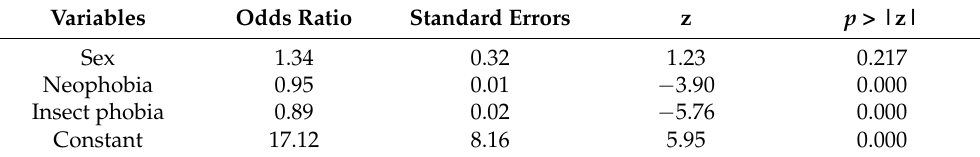
Table 7. Results of the second logit model (Model 2) of the intention to eat food that contains insects. Variables Odds